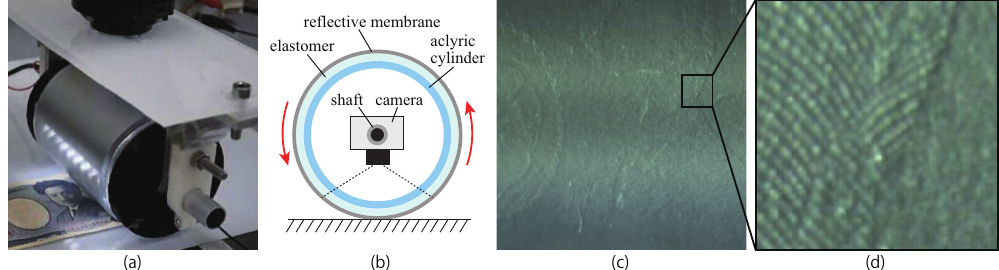
Figure 6. ( a ) Standard shape of the sensor with the flat sensing skin. ( b ) Reducing the thickness of the sensor using a mirror in [101]. ( c ) The inside of the cylinder can be seen using a perspective camera, such as that used in [97,98].